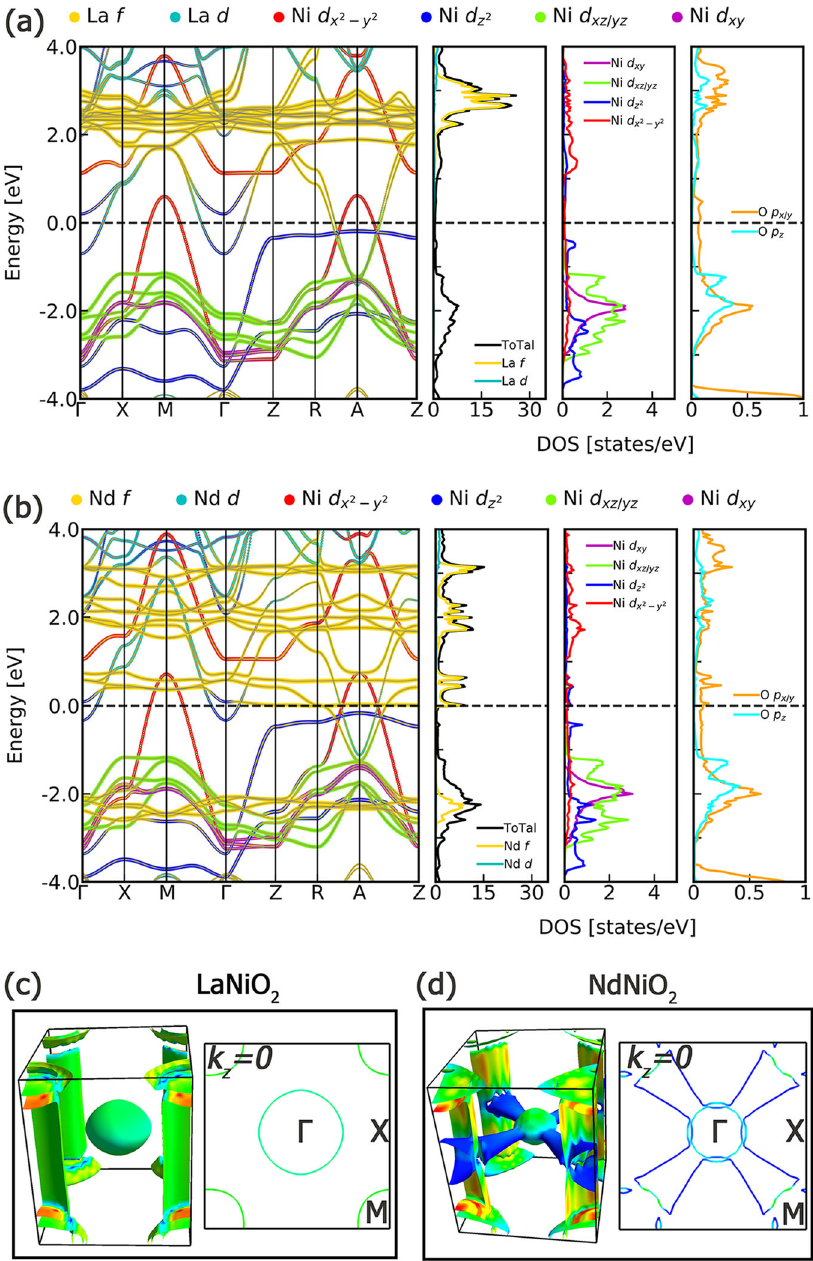
Fig. 5 The calculated electronic structures and Fermi surfaces of ferromagnetic (FM) phase. Orbitally-projected electronic structures of FM phase of a LaNiO 2 and b NdNiO 2 . c The calculated Fermi surface of LaNiO 2 and the projection of the Fermi surface on k z = 0 plane. d Same as c but for NdNiO 2 . Red and blue colors identify portions of the Fermi surface where the Fermi velocity is maximum and minimum, respectively. The Fermi velocity lies in-between the maxima and minima in the green